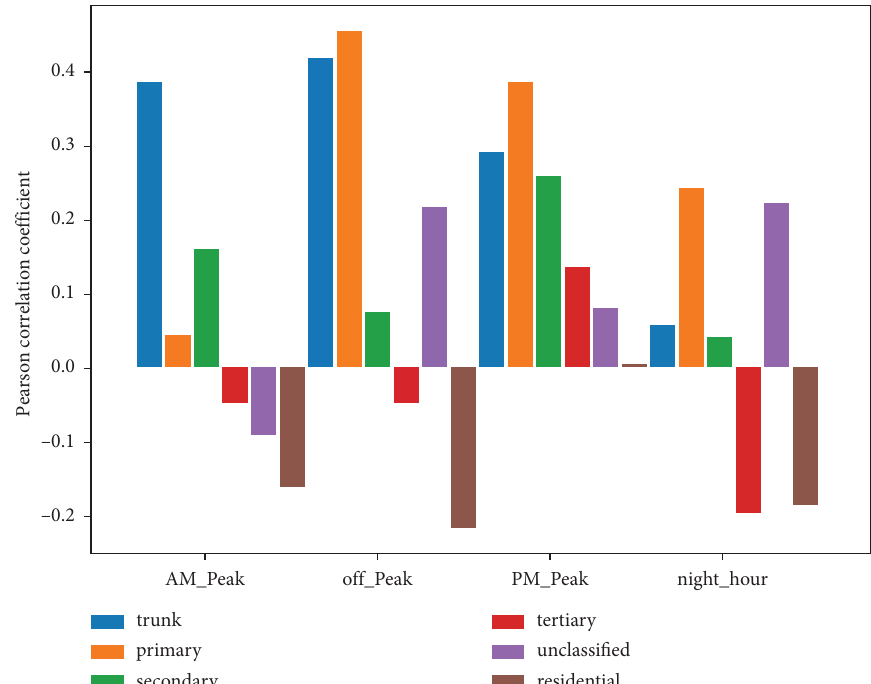
Figure 8: Correlation between the scale of POIs and road congestion levels of diferent ranks of road. Te scale of POI in the evening peak is positively correlated with the TPI of the road on all roads, and the correlation is most prominent on primary roads and secondary roads. Te scale of POI shows a positive relationship with the TPI on trunk roads and secondary roads during the morning peak, but other ranks of roads have a negative